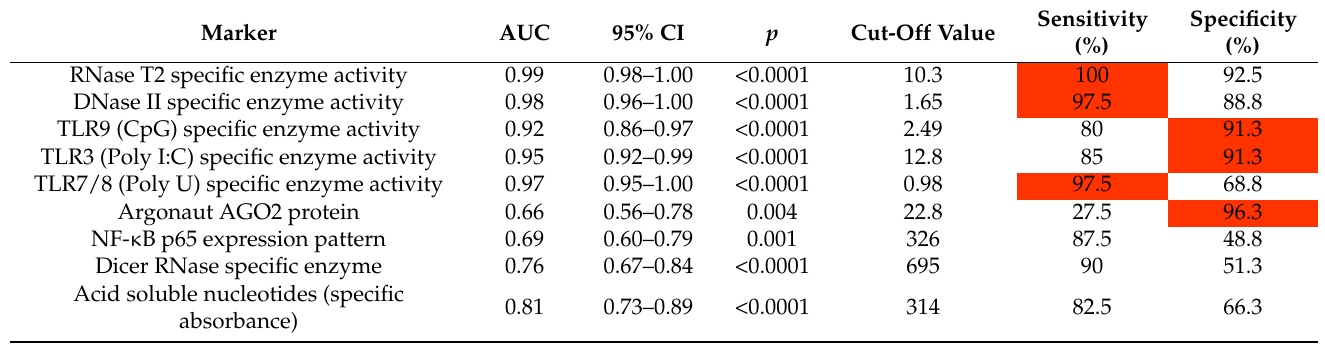
Figure 4. Receiver operating characteristic curve (ROC) of studied enzymes and proteins in PC. ROC showing the performance of studied enzymes and proteins, in patients with PC. Table 2. Areas under the curves, the optimal cut-off values by Youden’s index, sensitivity and specificity of studied enzymes and proteins in PC (values above 90% are marked